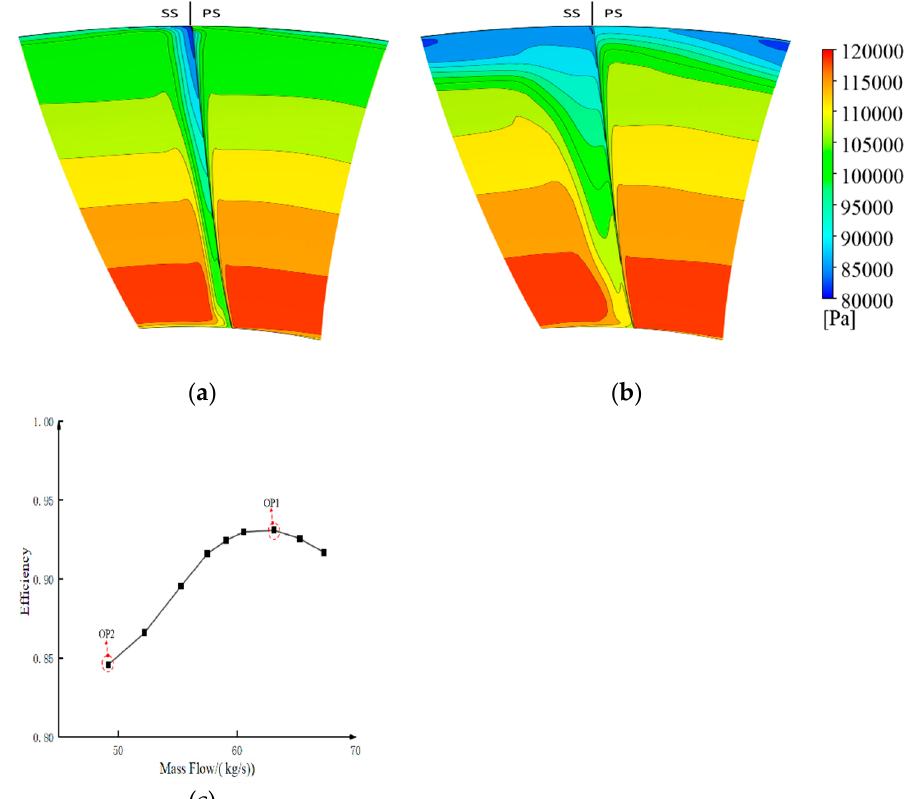
Figure 4. Relative total pressure contour at the rotor outlet section. ( a ) operation point 1 (OP1); ( b ) OP2; ( c ) position of OP1 and OP2.